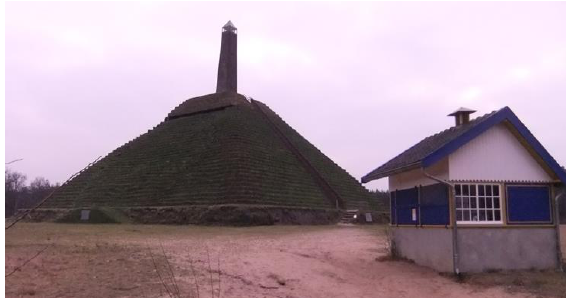
Figure 2: Pyramid of Austerlitz, January 2012.